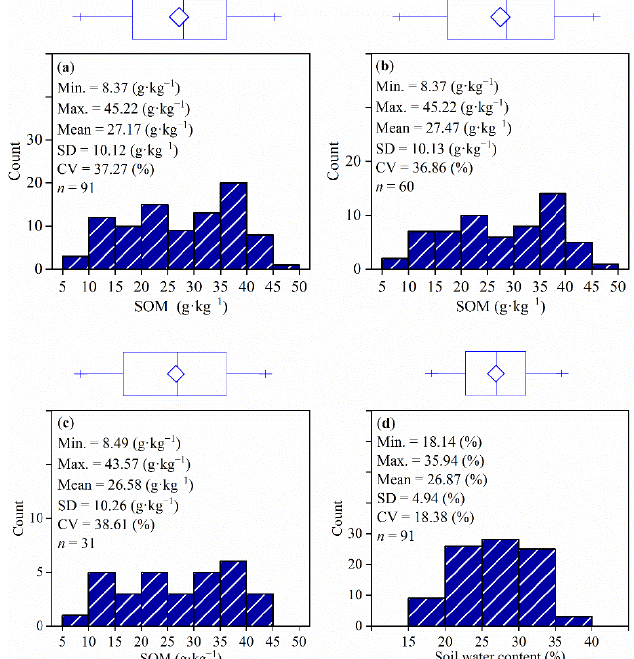
Figure 2. Box-plots, histograms and descriptive statistics of soil organic matter (SOM) and soil water content: ( a ) the whole dataset for SOM; ( b ) the calibration dataset for SOM; ( c ) the validation dataset for SOM; and ( d ) the whole dataset for soil water content. Min.: minimum, Max.: maximum, SD: standard deviation, CV: coefficient of variation.